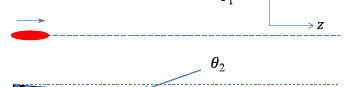
FIG. 18. Dechirper with x-rotation error. Anticlockwise (clock- wise) rotation corresponds to positive (negative) angle.